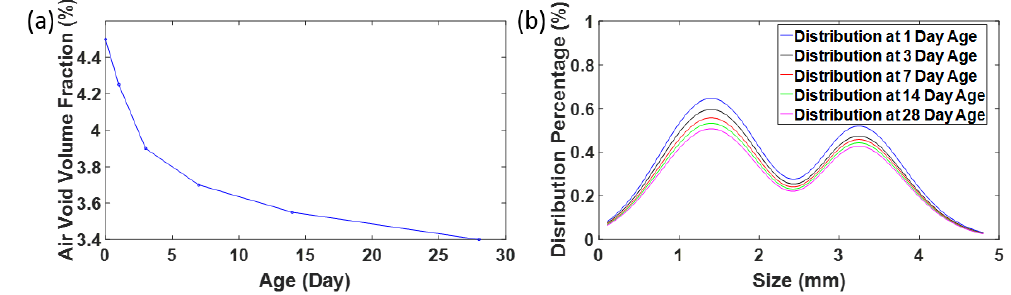
Figure 6. Air voids evolution for Sample Type 1. ( a ) The change of air void content with curing age measured with ultrasonic scattering (at early stages Days 1–28) and the ASTM C138 (Day 0); ( b ) Air void size distribution evolution with curing time.